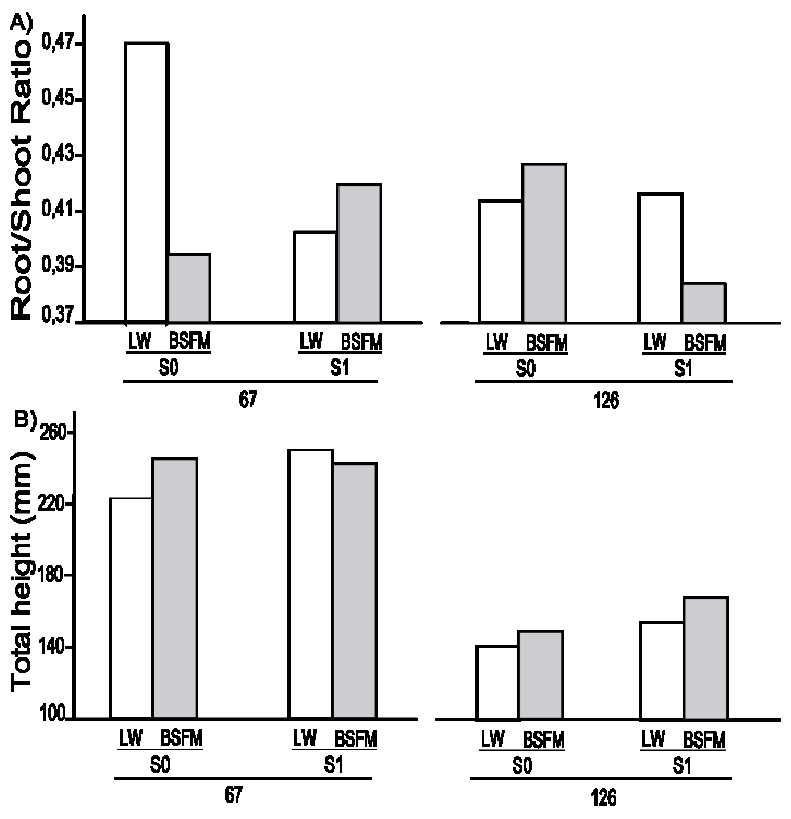
Figure 3. Stand types * Site preparation * Planting stock interaction effects on ( A ) root/shoot dry mass ratio ( R / S ) and ( B ) total height of containerized black spruce seedlings planted in lichen woodlands and black spruce feather-moss stands, one year after plantation ( n = 18 for each